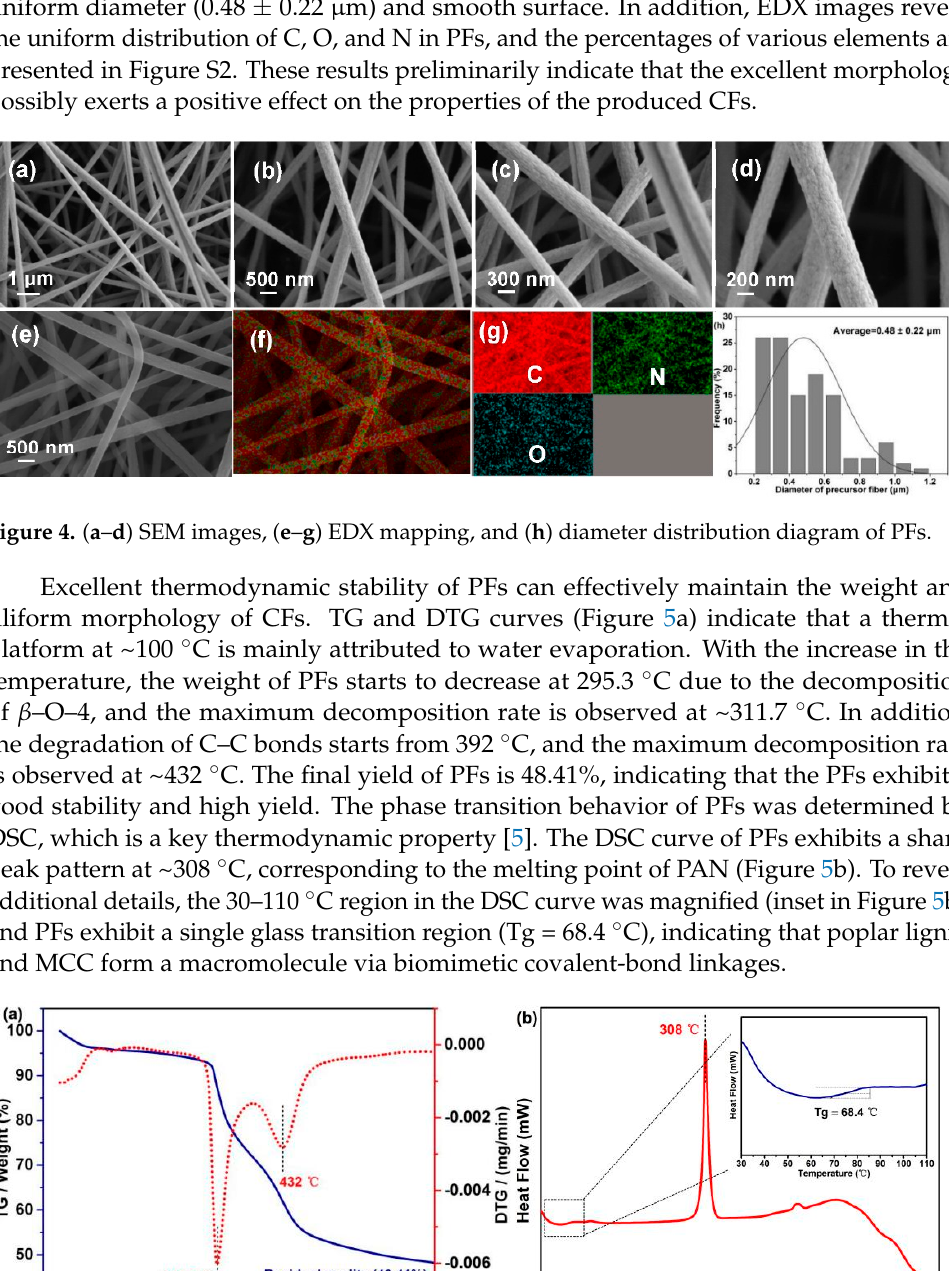
Figure 3. ( a ) XPS survey spectra of the samples. High ‐ resolution XPS ( b ) C 1s spectrum and ( c ) N 1s spectrum of the samples.